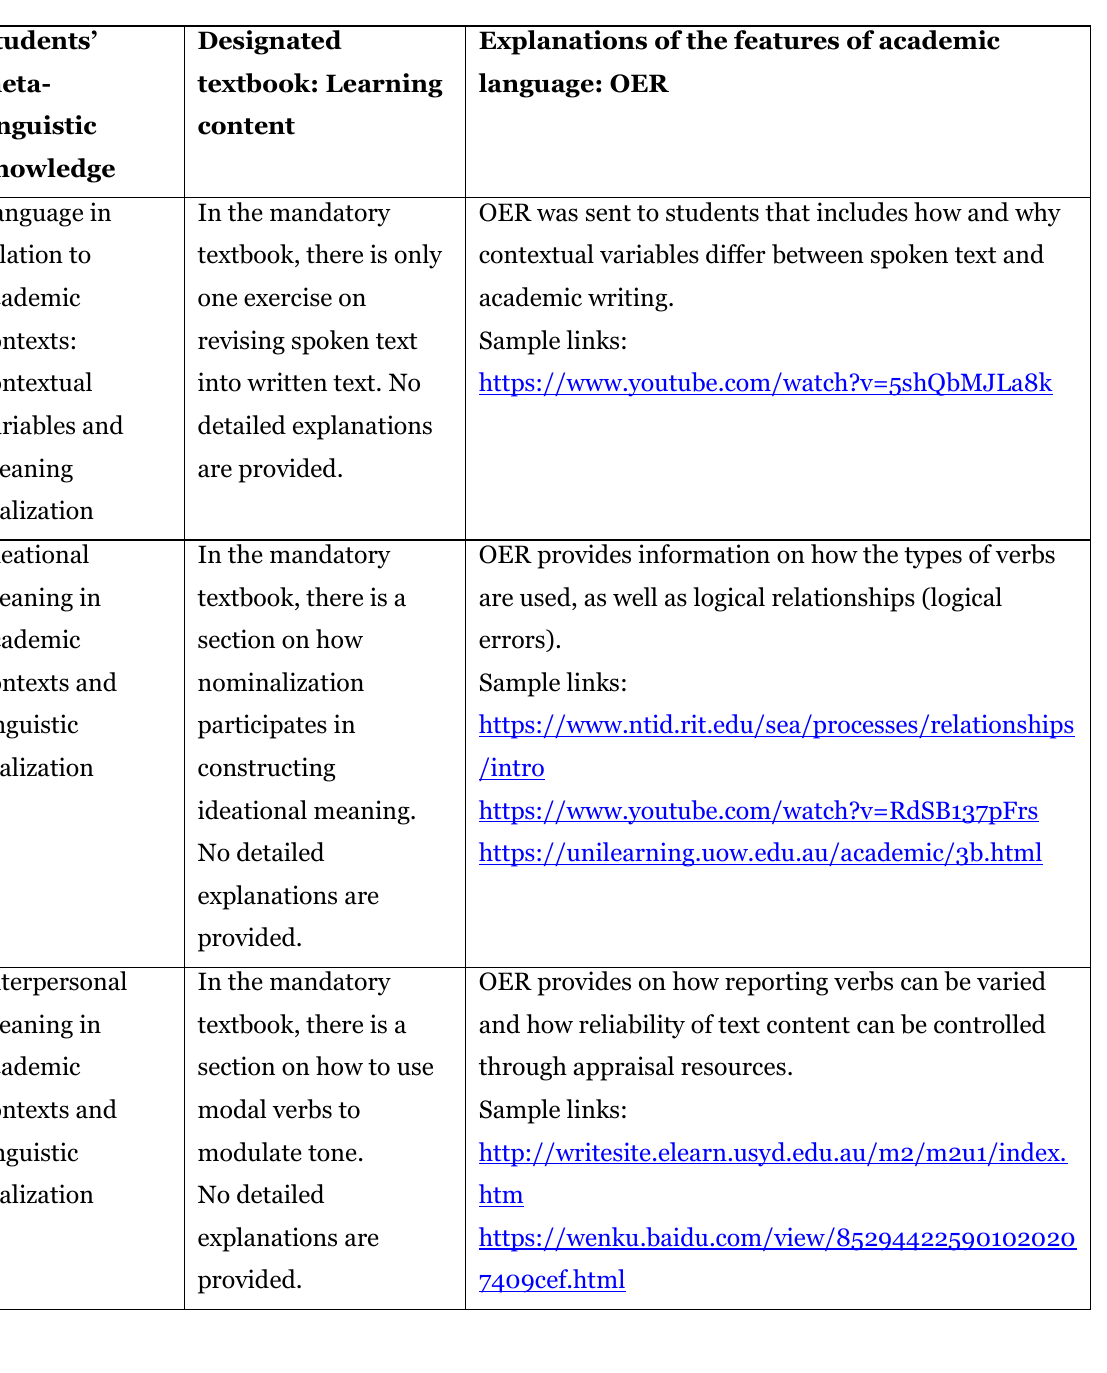
A Blended Curriculum: Designated Textbook and Sample